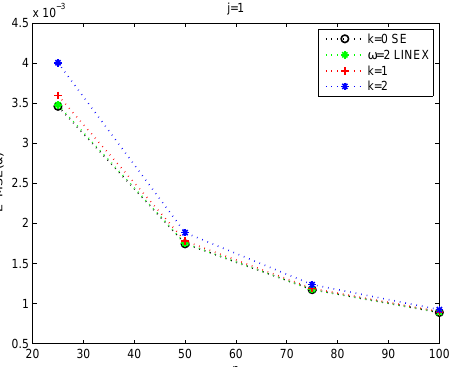
Figure 3. Relationship between n and EMSE(ˆ α ) ( k =